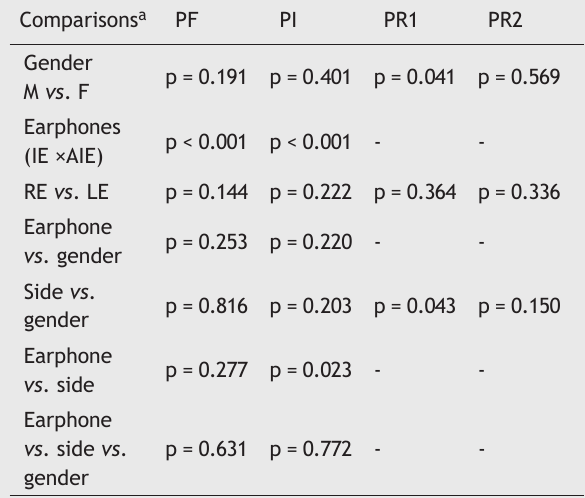
Table 2 ANOVA results for repeated measures for comparison (sound pressure level between headphones, sides, and gen- ders) considering PF, PI, PR1, and PR2.